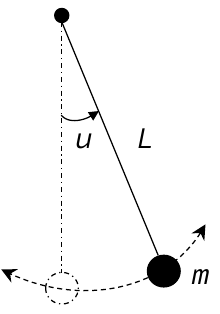
Figure 5. A simple pendulum.